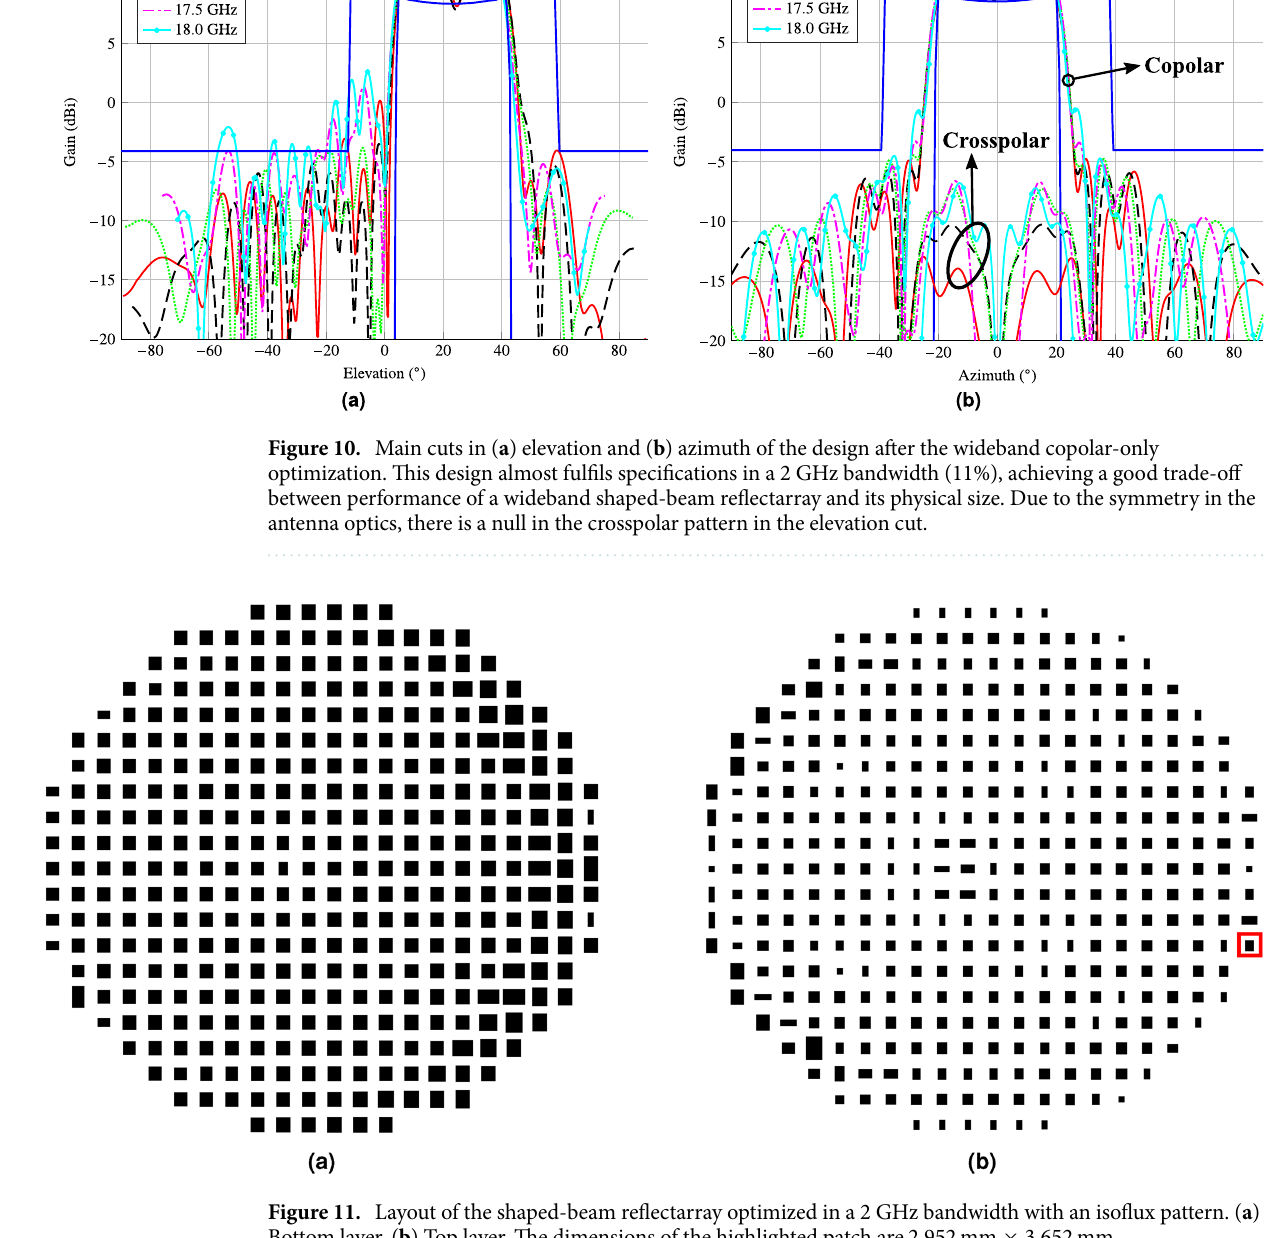
Figure 11. Layout of the shaped-beam reflectarray optimized in a 2 GHz bandwidth with an isoflux pattern. ( a ) Bottom layer. ( b ) Top layer. The dimensions of the highlighted patch are 2.952 mm × 3.652 mm